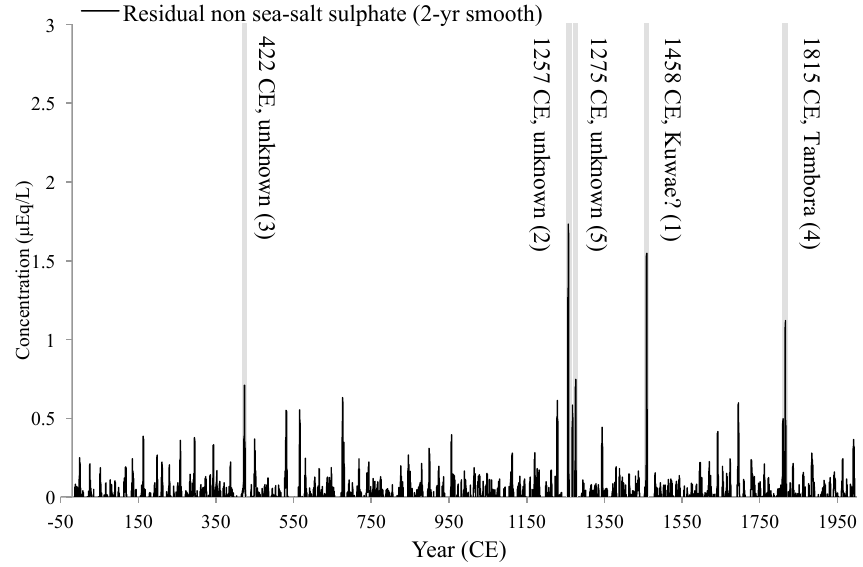
Fig. 1. The Law Dome residual non-sea-salt sulphate record.The peaks shaded in grey represent the five highest event fluxes, with the number in brackets signifying event size rank in the Law Dome record (1 being the highest). A 2-yr smooth was used for illustrative purposes.